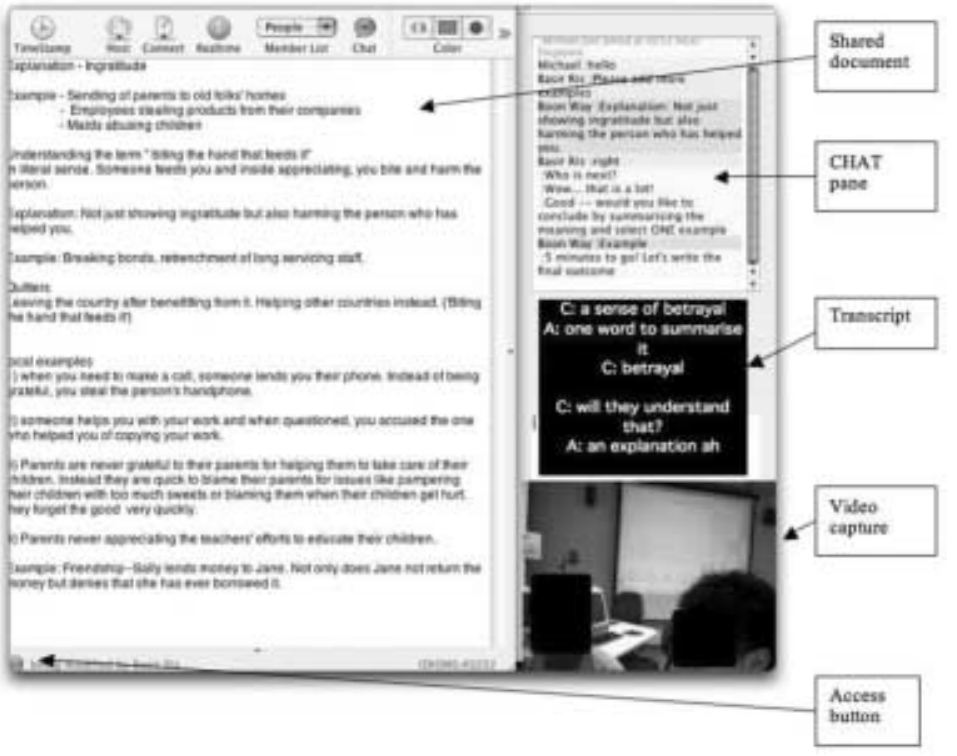
Figure 2. Screen capture actions and